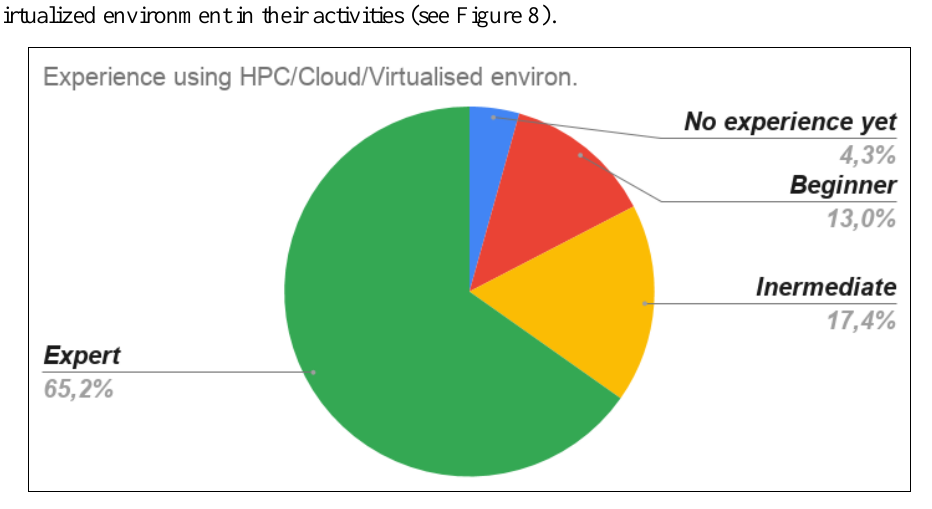
Figure 8. Suppliers' experience using HPC, Cloud and Virtualised